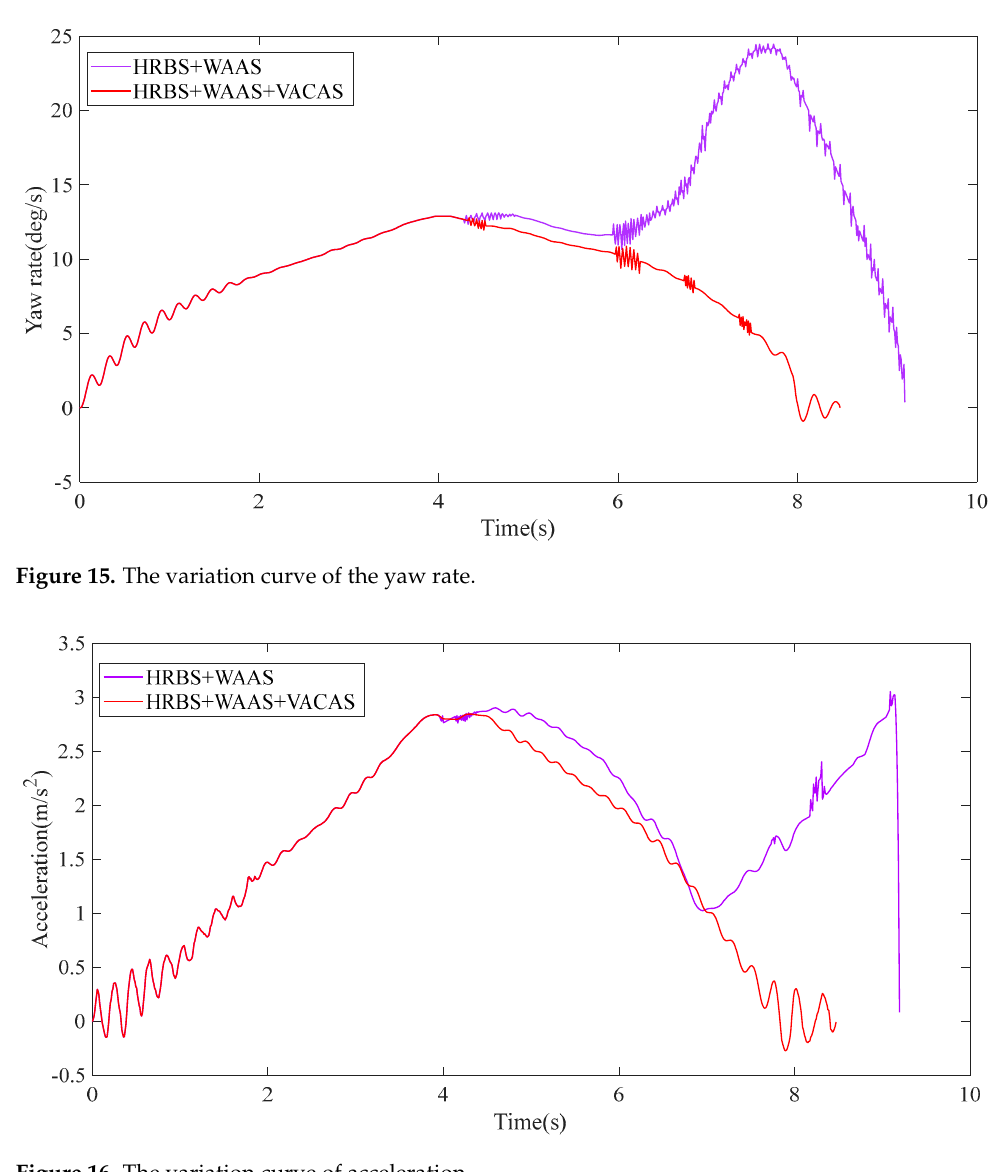
Figure 17. The variation curve of the sideslip angle.